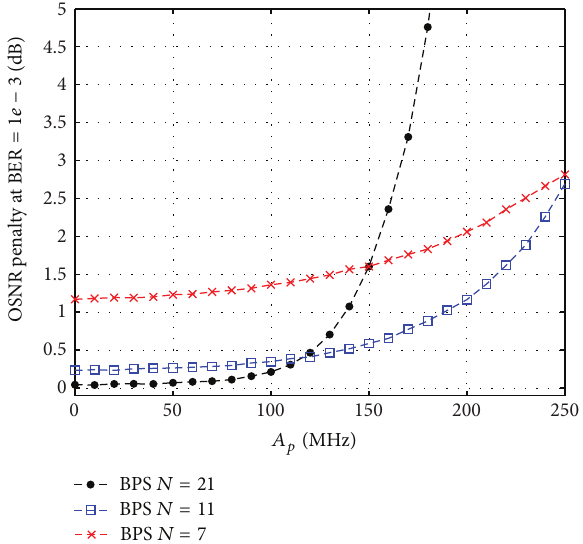
Figure 5: Performance of VV CPR with QPSK modulation versus the frequency deviation amplitude ( 𝐴 𝑝 ) for Δ𝑓 𝑐 = 35 KHz, 1/𝑇 = 32 Gs/s, and Δ ] = 250 KHz.